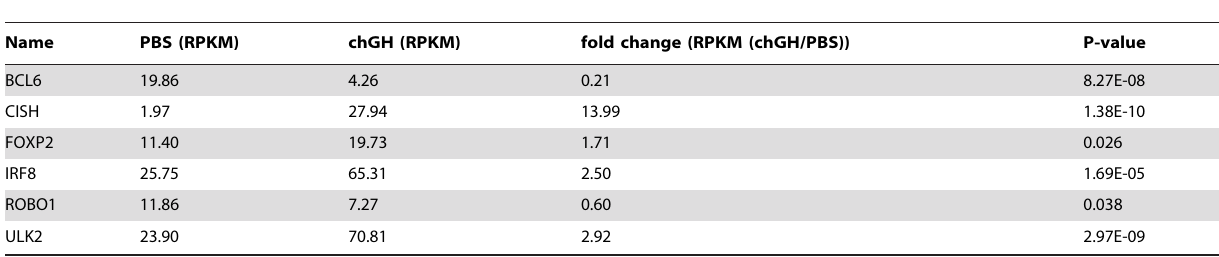
Table 4. List of growth-related mRNAs whose expression in chicken hepatocytes was regulated by chGH.